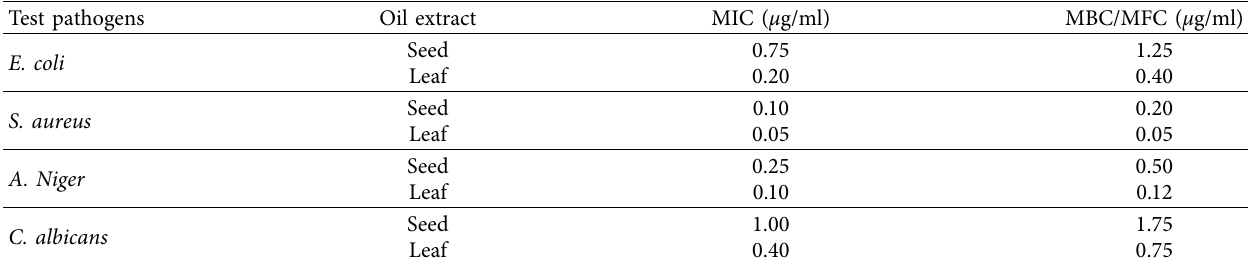
Table 4: MIC, MBC, and MFC of garden cress seed and leaf oil extracts. Test